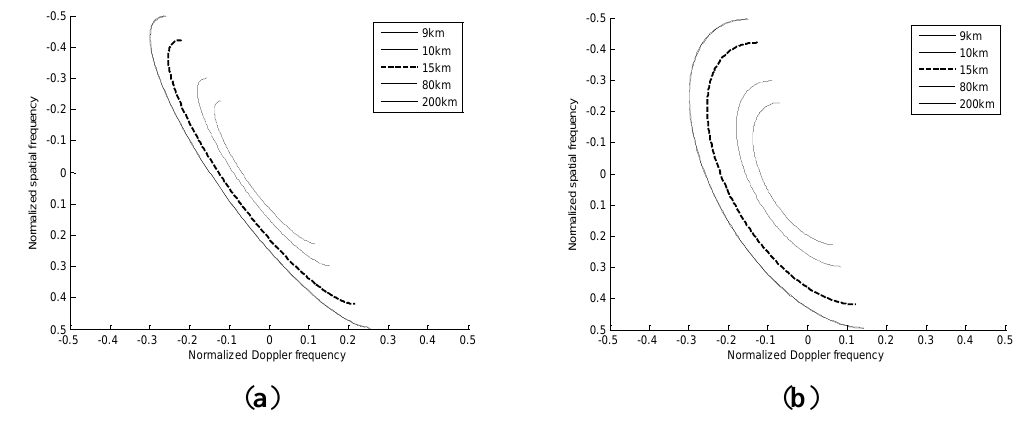
Figure 2. Angle-Doppler trajectories of different range cells. ( a ) ψ = 30°; ( b ) ψ = 60°.